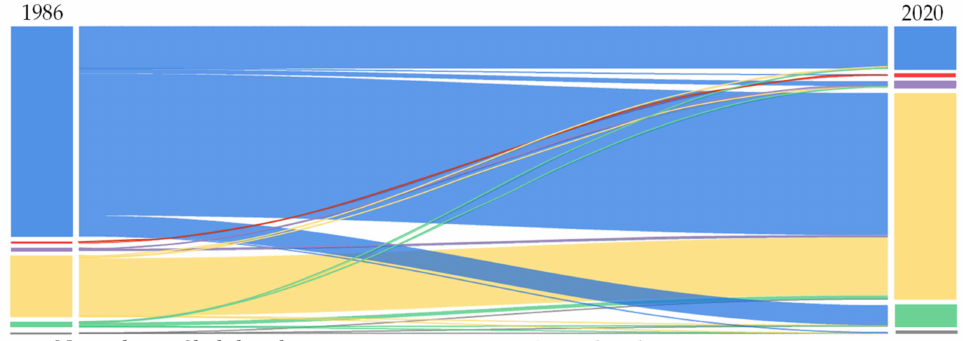
Figure 9. Changes in soil salinity type from 1986 to 2020 in the South Aral